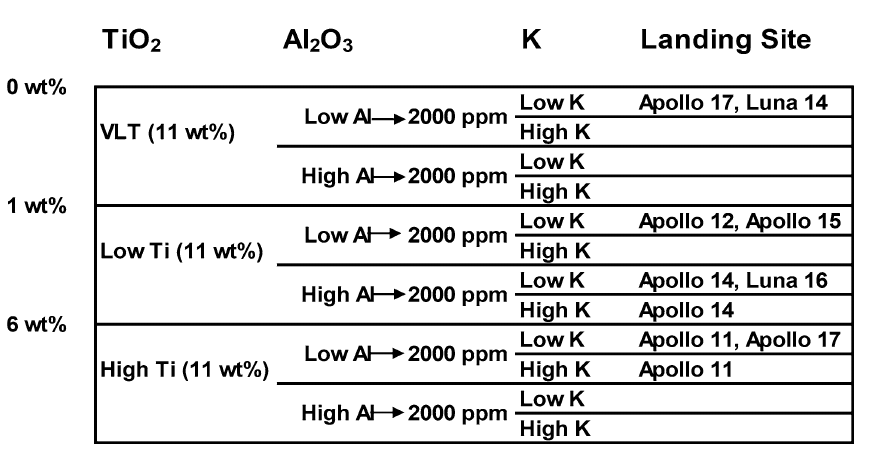
Figure 3. Neal & Taylor 16 classification diagram, where it is compared the values of Fig. 2. to establish a direct relation between the different regolithic simulants and the lunar landing